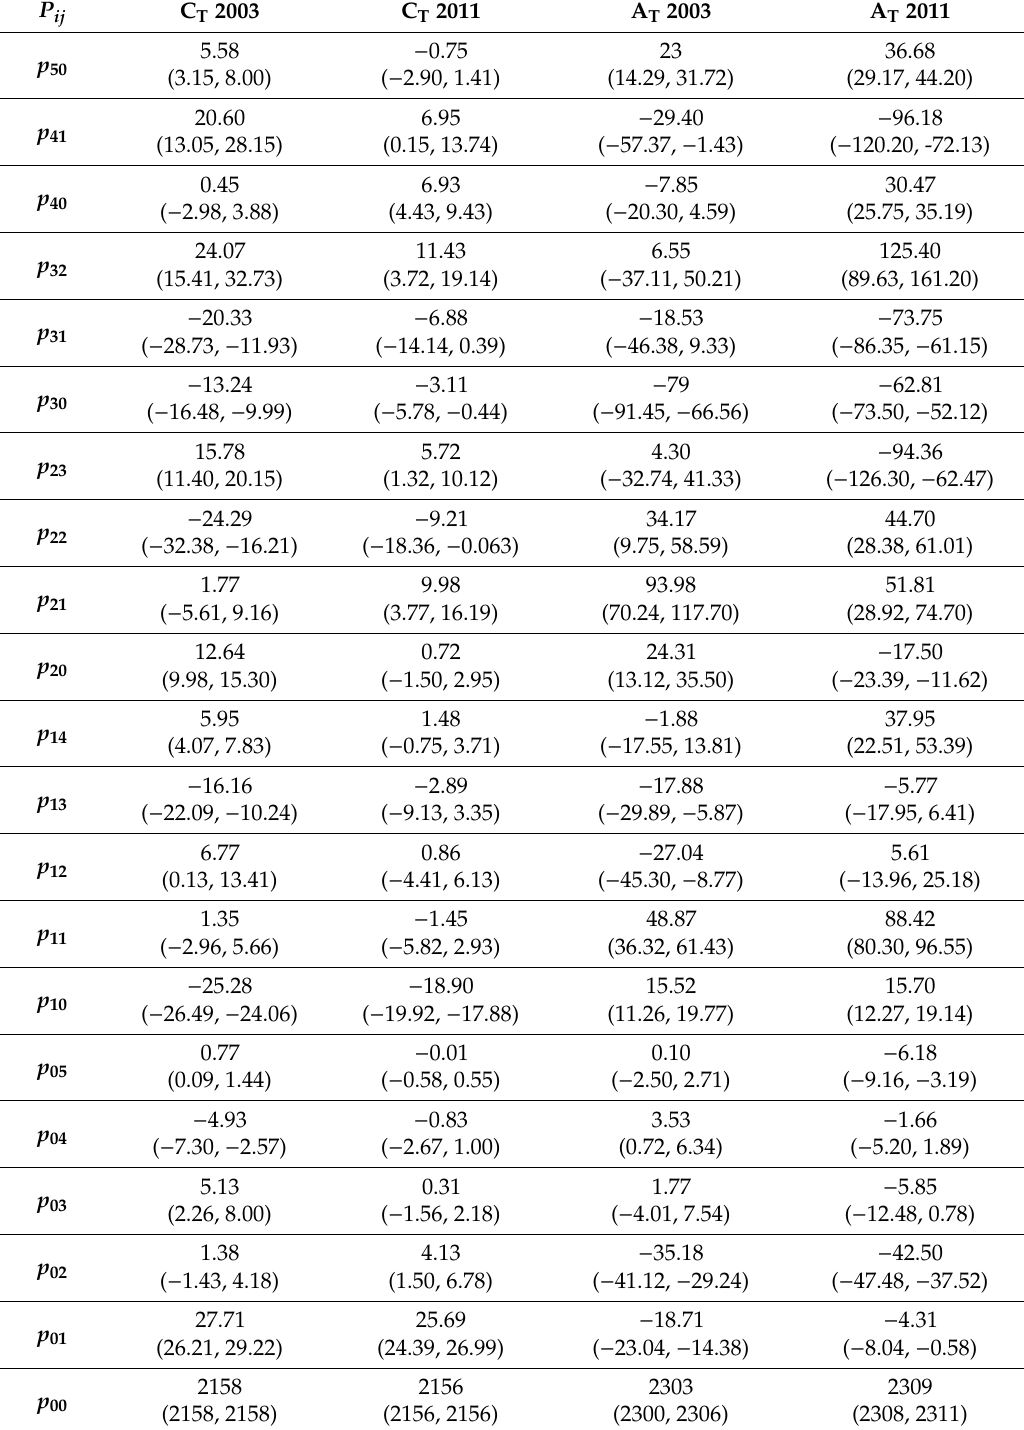
Table 2. The pij coe ffi cients (with 95% confidence bounds) of the polynomial models developed for C T and A T , according to Equation